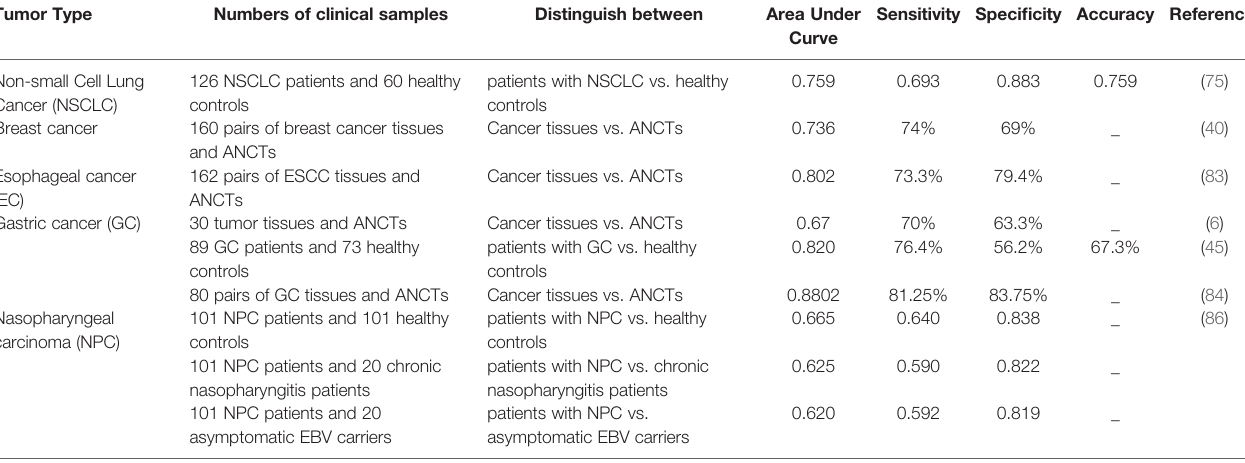
TABLE 4 | Diagnostic value of AFAP1-AS1 in different cancers. Tumor